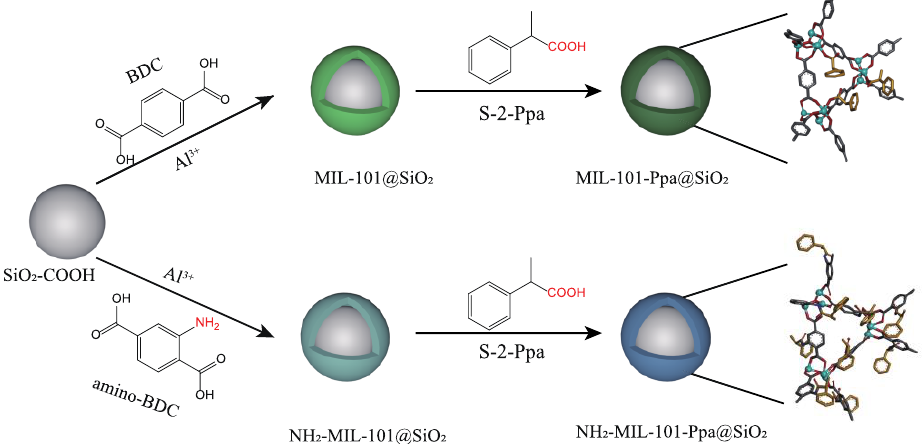
Scheme 1. Schematic illustration of the structures of MIL − 101 − Ppa@SiO 2